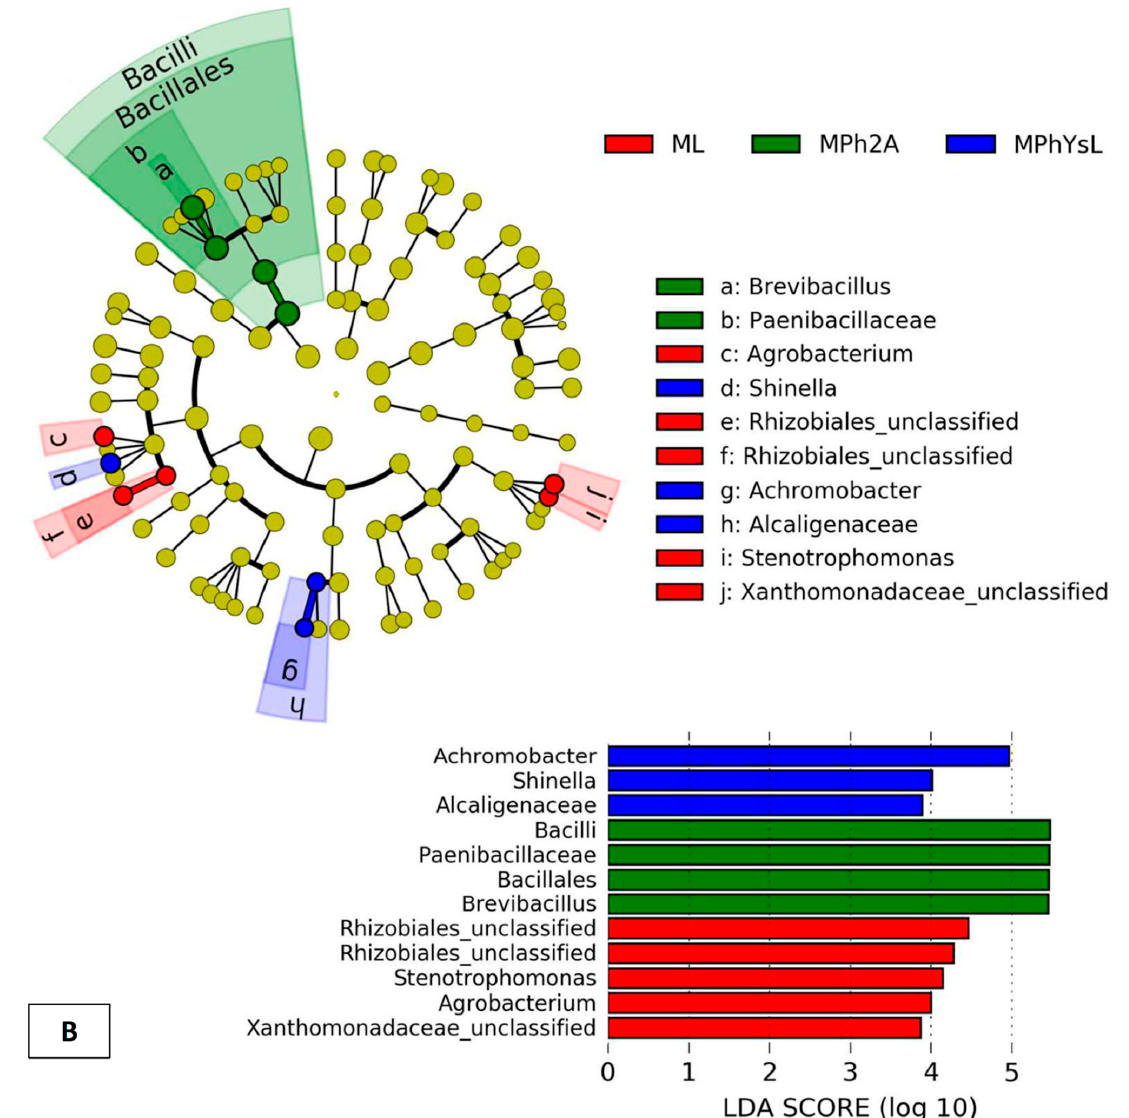
Figure 5. Phylogenetic dendrogram of biomarkers identified in various combinations of tested culture media: ( A ), ML and MPhYmL, MPhYmH; ( B ), ML, R2A, MPhYsL, and MPhYsH. The circles from inside to outside indicate bacterial taxonomic levels from phylum to genus. Yellow dots rep- resent bacteria that do not vary significantly in relative abundance. Biomarker bacteria are colored according to the corresponding colors on the right. LDA scores of biomarkers, as calculated in the Kruskal–Wallis rank sum test, p < 0.05. ML, culture-independent mother leaf; MPhYmH, cul- ture-dependent on homologous maize broth 25 ml L −1 ; MPhYmL, culture-dependent on homolo- gous maize broth 5 ml L −1 ; MPhYsH culture-dependent on heterologous sunflower broth 25 ml L −1 ; MPhYsL, culture-dependent on heterologous sunflower broth 5 ml L −1 ; MPh2A, culture-dependent of R2A culture medium.